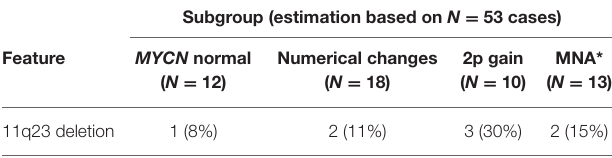
TABLE 2 | The status of 11q23 deletion in the study group.